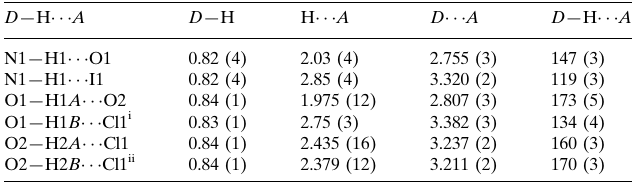
Hydrogen-bond geometry (A˚ , (cid:3)